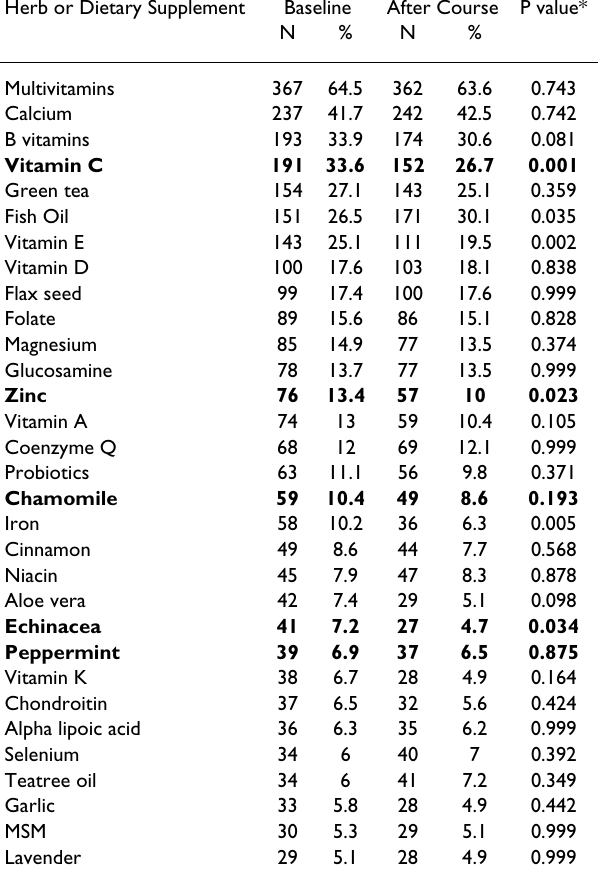
HDS Herb or Dietary Supplement Baseline